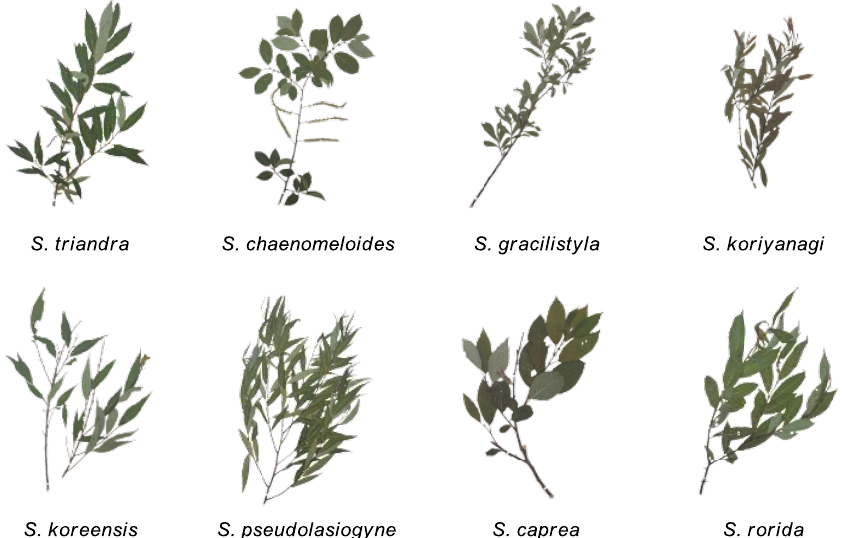
Figure 1. Specimens of the eight collected Salix species ( S. triandra , S. chaenomeloides , S. gracilistyla , S. koriyanagi , S. koreensis , S. pseudolasiogyne , S. caprea , and S. rorida ).